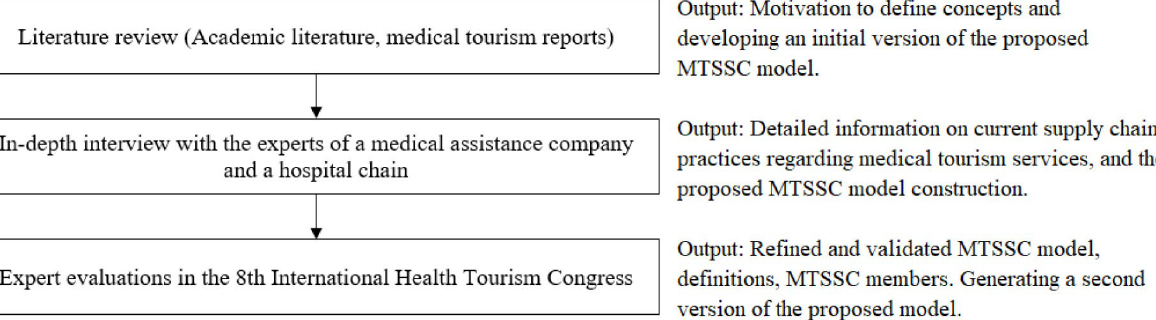
Figure 1. The triangulation process used in this